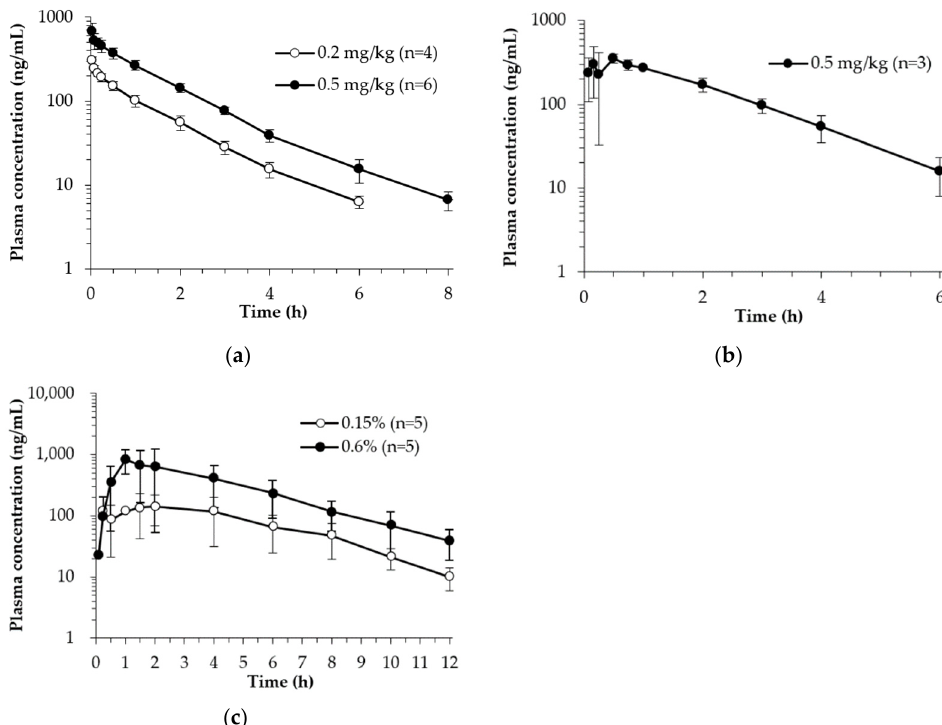
Figure 3. Average plasma concentration–time profiles of hexamethylenetetramine obtained after ( a ) iv injection (0.2 and 0.5 mg/kg), ( b ) oral (0.5 mg/kg), and ( c ) percutaneous administration (0.15 and 0.6%) in rats.